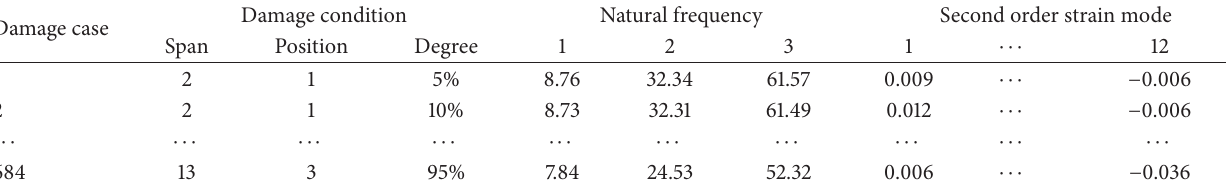
Table 4: Minimum property set 2 after reduction.